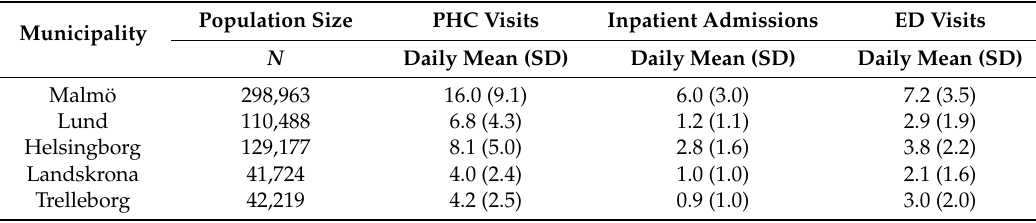
Table 2. Population size and descriptive statistics of primary health care (PHC) visits, inpatient admissions, and emergency department visits in the five municipalities during the study period (2005–2010). Population Size PHC Visits Inpatient Admissions ED Visits Municipality Daily Mean